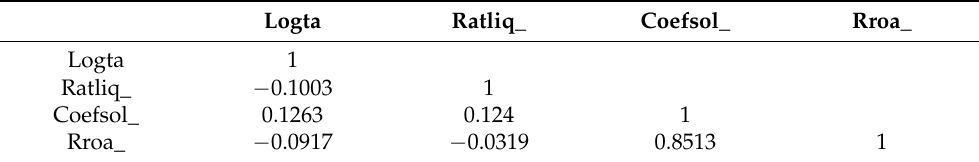
Table 9. Correlation coefficient between control variables.